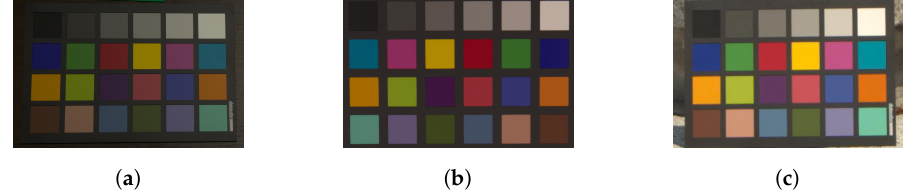
Figure 2. Color rendition charts under different light sources. ( a ) Ground truth color rendition chart, ( b ) color rendition chart under artificial light source, and ( c ) color rendition chart under